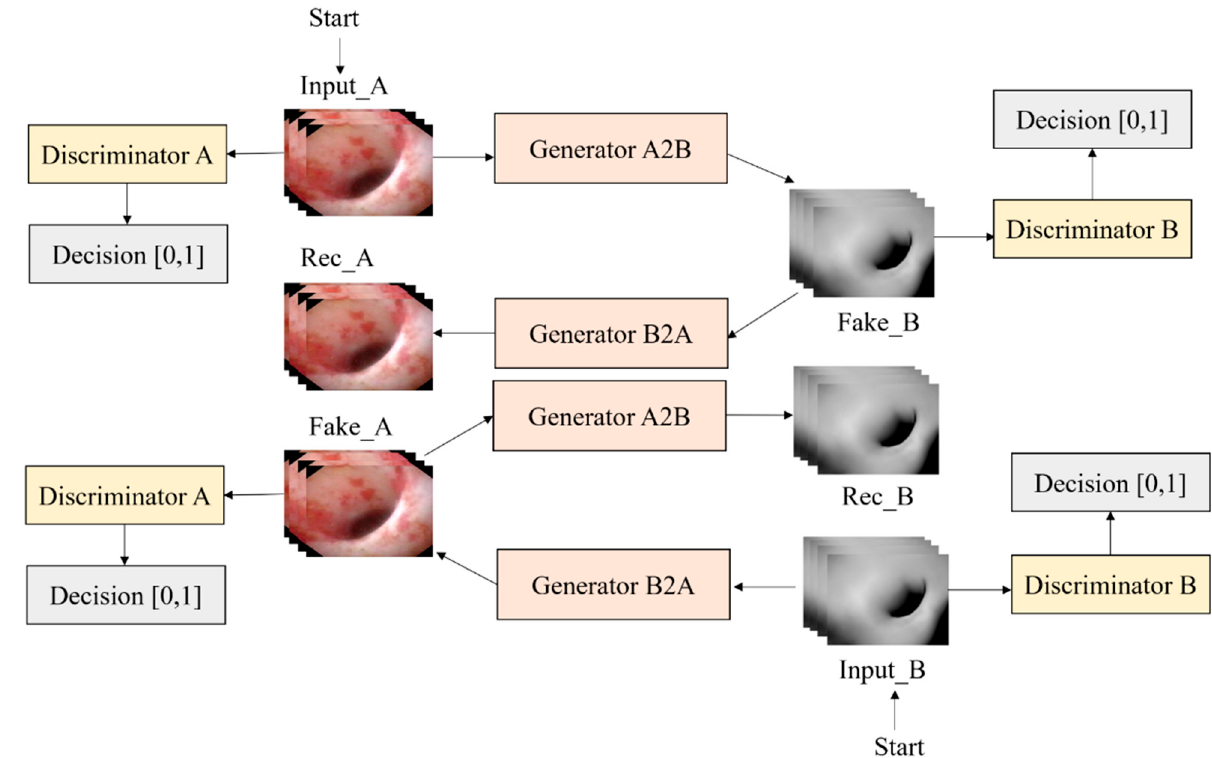
Figure 3. A style migration model of CycleGAN was used to transform white light images into virtual endoscopic images.